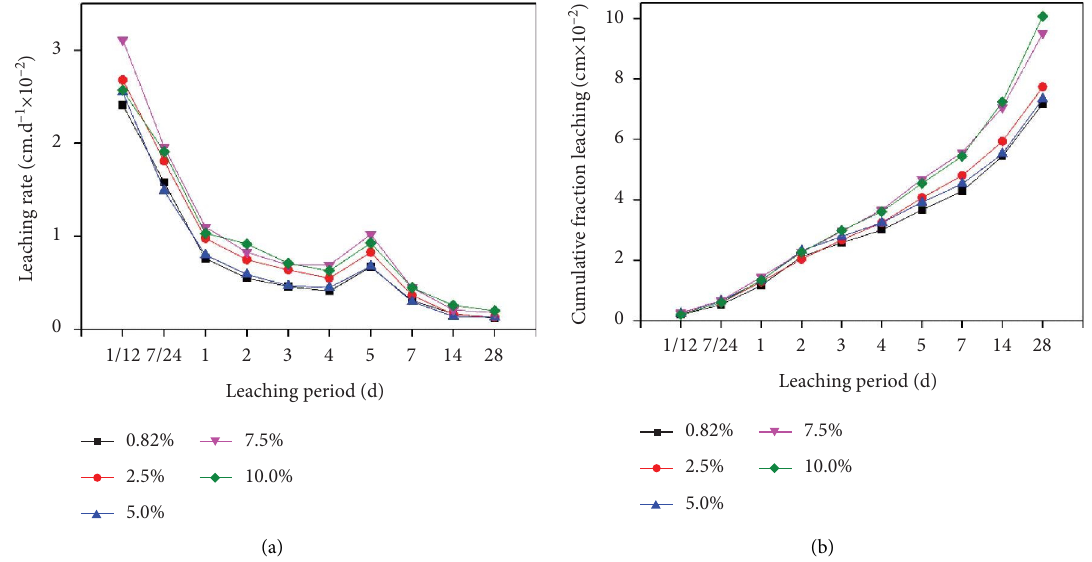
Figure 17: Te leaching curves of Ca 2+ in the SFCM with diferent sodium hydroxide contents at a sodium nitrate concentration of 300g/L: (a) LF of Ca 2+ ; (b) CLF of Ca 2+